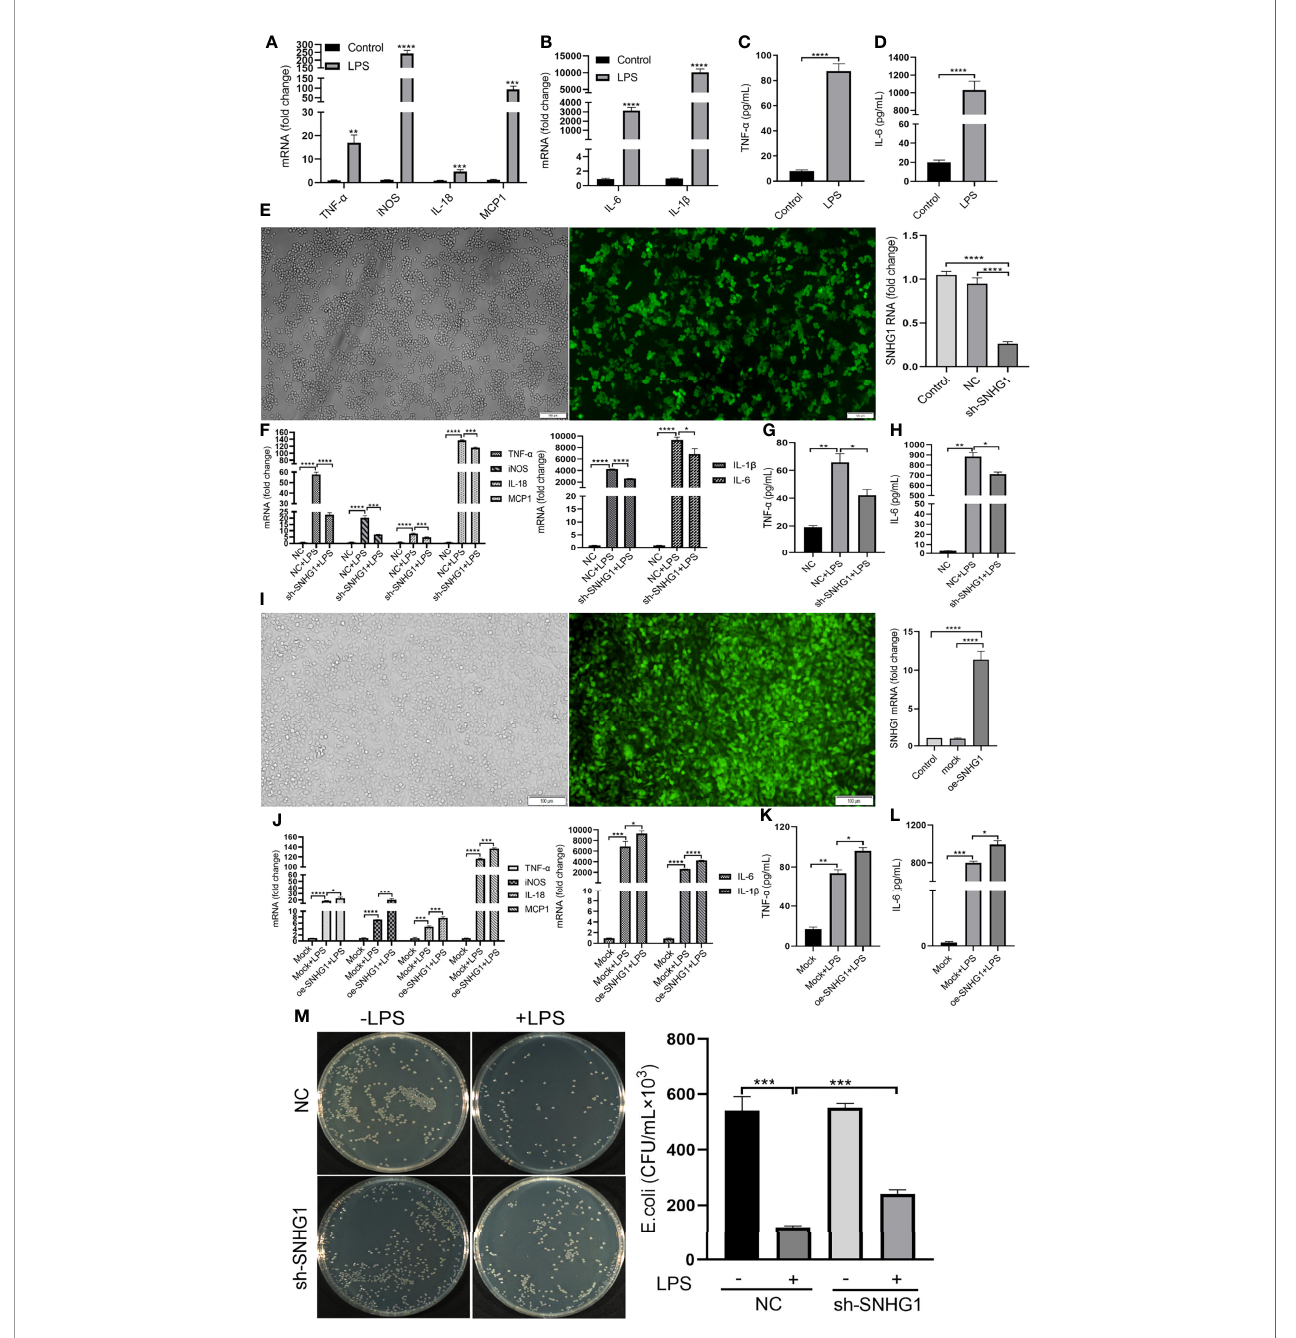
FIGURE 3 | SNHG1 regulates macrophage polarization. (A, B) Expression of proin fl ammatory cytokines (TNF- a , iNOS, IL-18, MCP-1, IL-6 and IL-1 b ) in RAW264.7 cells treated with LPS, as determined by qRT-PCR. (C, D) Expression of proin fl ammatory cytokines (TNF- a , IL-6) in RAW264.7 cells treated with LPS, as determined by ELISA. (E) The ef fi ciency of SNHG1 in RAW264.7 cells transfected with lentivirus sh-SNHG1 was determined by qRT-PCR. (F) Expression of proin fl ammatory cytokines (TNF- a , iNOS, IL-18, MCP-1, IL-6 and IL-1 b ) in RAW264.7 cells transfected with lentivirus sh-SNHG1 treated with LPS, as determined by qRT-PCR. (G, H) Expression of proin fl ammatory cytokines (TNF- a , IL-6) in RAW264.7 cells transfected with lentivirus sh-SNHG1 treated with LPS, as determined by ELISA. (I) The ef fi ciency of SNHG1 in RAW264.7 cells transfected with lentivirus oe-SNHG1 was determined by qRT-PCR. (J) Expression of proin fl ammatory cytokines (TNF- a , iNOS, IL-18, MCP-1, IL-6 and IL-1 b ) in RAW264.7 cells transfected with lentivirus oe-SNHG1 treated with LPS, as determined by qRT-PCR. (K, L) Expression of proin fl ammatory cytokines (TNF- a , IL-6) in RAW264.7 cells transfected with lentivirus oe-SNHG1 treated with LPS, as determined by ELISA. (M) Bacterial killing assay was performed in RAW264.7 cells transfected with lentivirus sh- SNHG1 treated with LPS or not. Data are indicated as the mean ± SD, * P <0.05, ** P <0.01, *** P <0.001, **** P